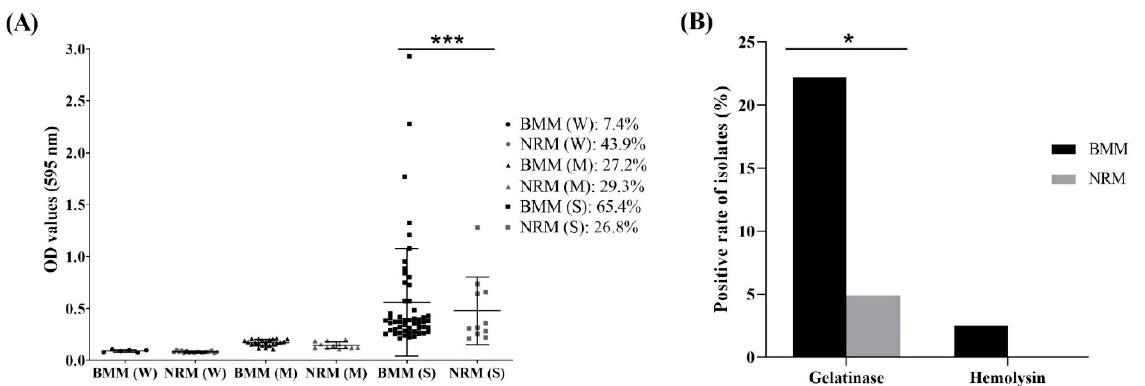
Figure 2. Distribution of Enterococcus faecalis and Enterococcus faecium isolated from bovine mastitis milk (BMM) and bovine normal raw milk (NRM) according to their virulence factors. ( A ) Biofilm formation ability (OD values) and ( B ) gelatinase and hemolysin production. Biofilm formation criteria comprised non-biofilm formation (optical density (OD) ≤ 0.052), weak biofilm formation (0.052 < OD ≤ 0.104), moderate biofilm formation (0.104 < OD ≤ 0.208), and strong biofilm formation (OD > 0.208). BMM: bovine mastitis milk, NRM: bovine normal raw milk, W: weak, M: moderate, S: strong. *** indicates significant difference in strong biofilm formation between the BMM (S) and the NRM (S) group ( p < 0.0001; Pearson’s chi-square test). * indicates significant difference in